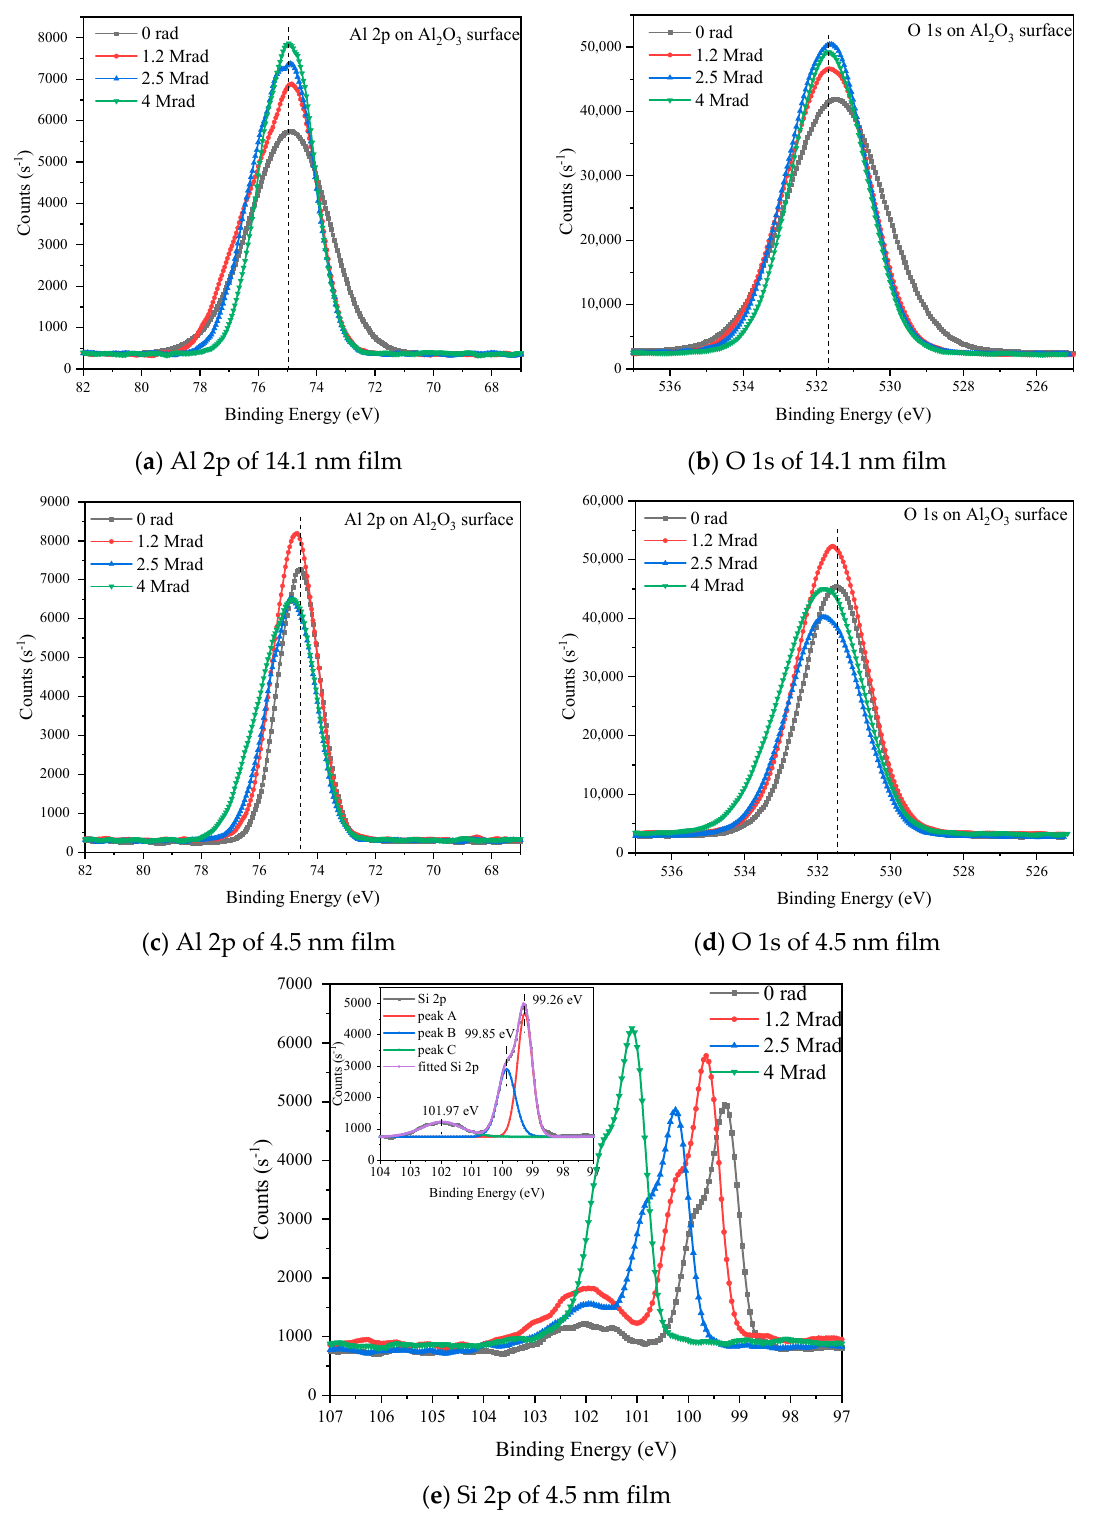
Figure 3. Detailed XPS results taken on the surface of Al 2 O 3 film.